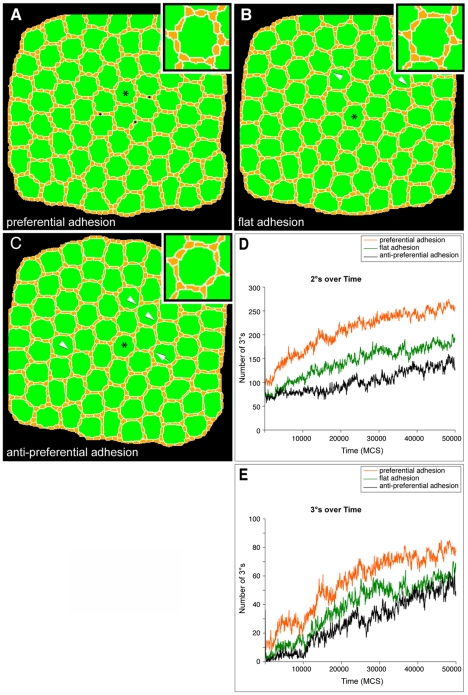
Adhesion did not affect formation of 2°s or 3°s in the presence of cell death.All images are final images from 50,000 MCS trials. (A) In a simulation in which IPCs were more adherent to OCs than to each other, 3°s and most 2°s emerged correctly at all central ommatidia. Several ectopic end-to-end 2°-like cells are indicated (•) (B) In a simulation in which OC:IPC and IPC:IPC adhesion was set as identical, 3°s still correctly emerged within all central ommatidia. An increase in cell death resulted in some missing 2°s (arrowheads). (C) 3°s also emerged within a simulation in which IPCs were more adherent to each other than to OCs; occasional loss of 3°s was observed (arrow). Increased cell death (PCD) resulted in missing 2°s (arrowheads). Asterisks label enlarged ommatidia (insets). (D and E) Graphs quantifying how in the presence of reduced cell death (L = 10), preferential adhesion most efficiently enhanced the ability of 2°s (D) and 3°s (E) to form. Each line represents the result of a single representative simulation from at least two repetitions. When OC:IPC adhesion was the same (‘flat adhesion’) or less (‘anti-preferential adhesion’) than IPC:IPC adhesion 2°s and 3°s still formed though less efficiently.